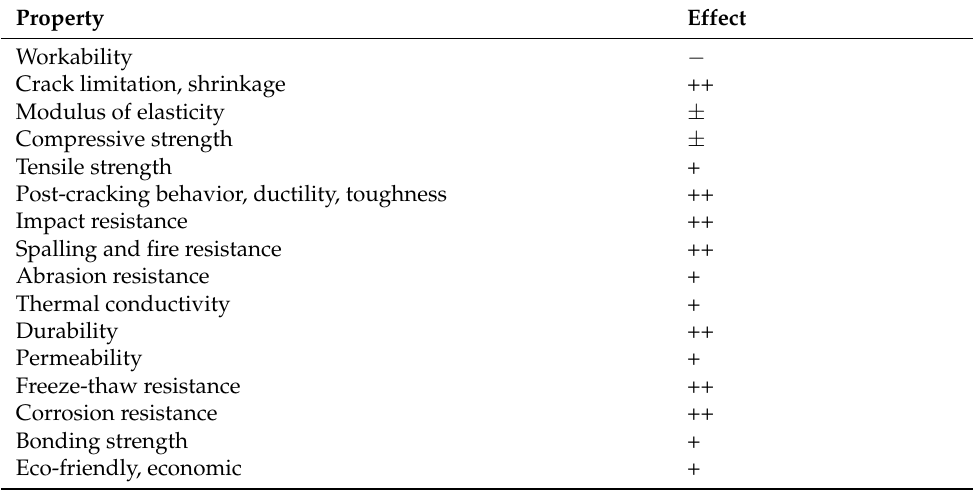
Table 6. Effect of GF addition on different concrete